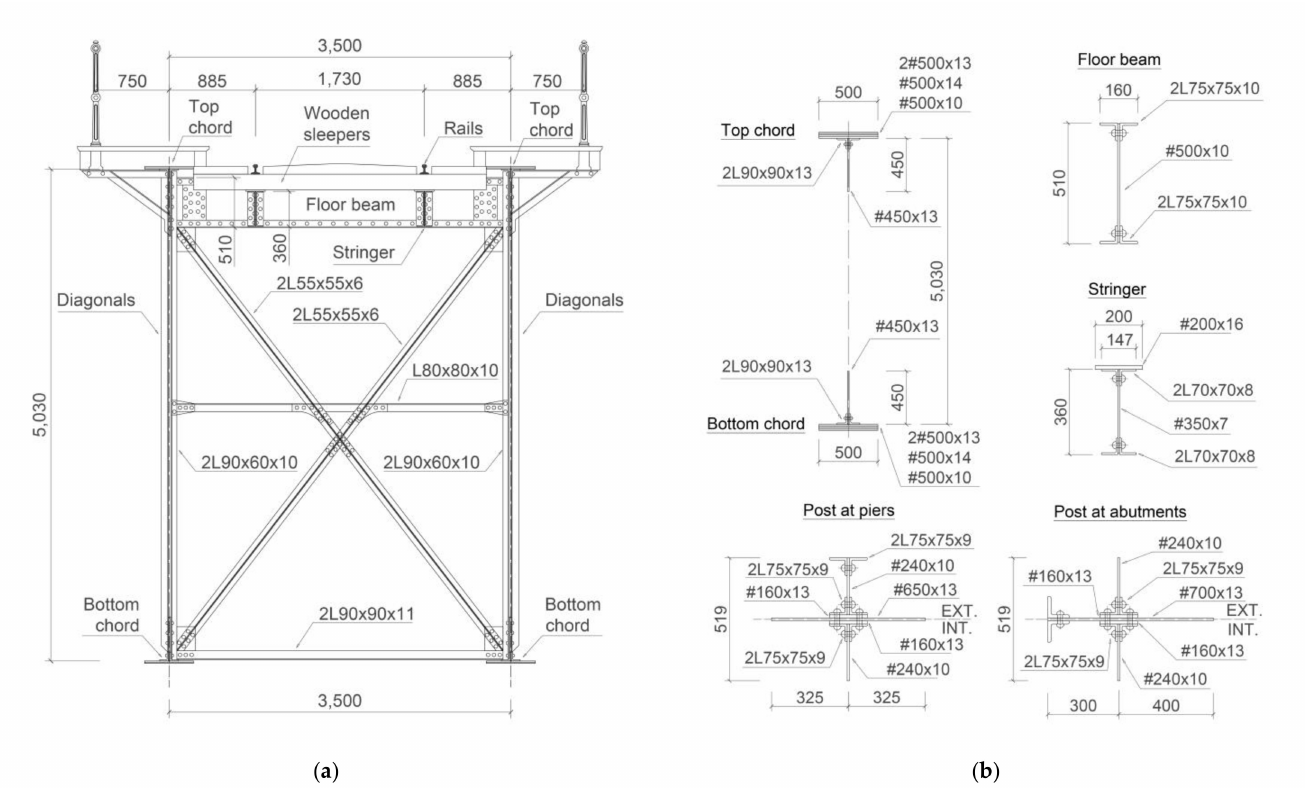
Figure 2. Redondela Bridge drawings: cross-sections (all dimensions in mm). ( a ) Bridge cross-section. ( b ) Element